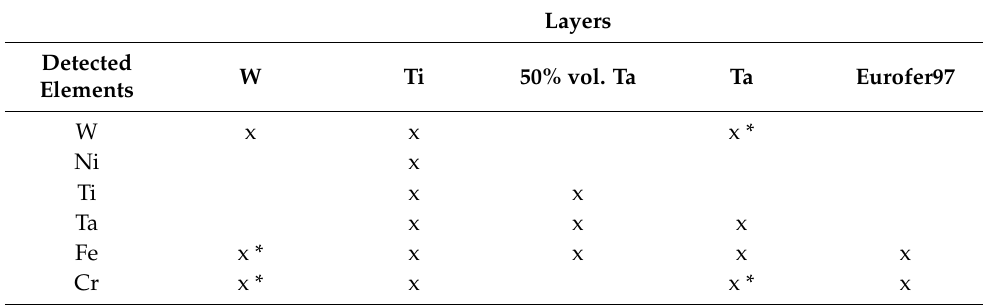
Figure 2. Complete joining of Eurofer97 to W via FGM interlayer (Ta, 50 vol.%Ta + 50 vol.%Ti, Ti) (SEM image with secondary electron contrast obtained with JEOL 840a). Table 6. Main elements detected in the different layers constituting the complete joining.